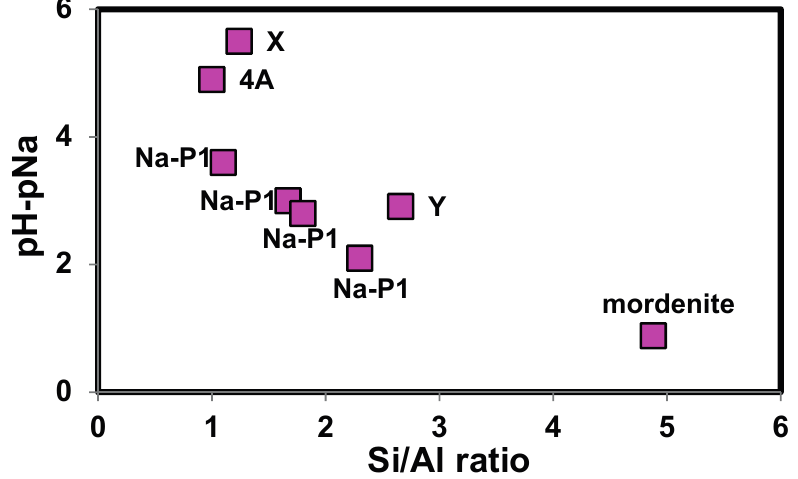
Figure 4. Correlation of (pH − pNa) 80 with Si/Al ratio of